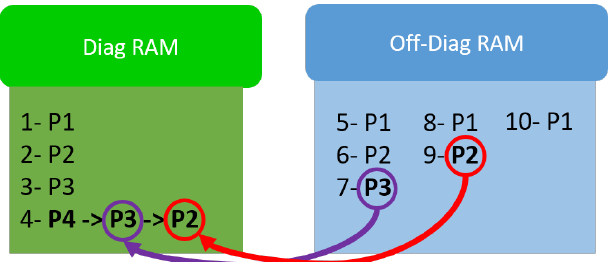
Figure 6. Order of data storage in the Diagonal and Off-diagonal RAMs inside the Cov unit.